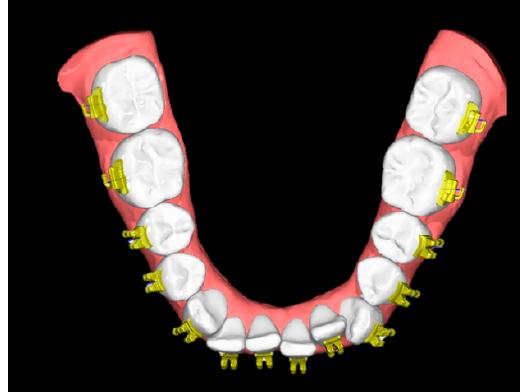
Figure 3. Reference model consisting of a digitized study model and the semiautomatically posi- tioned brackets/tubes (SMref). brackets/tubes